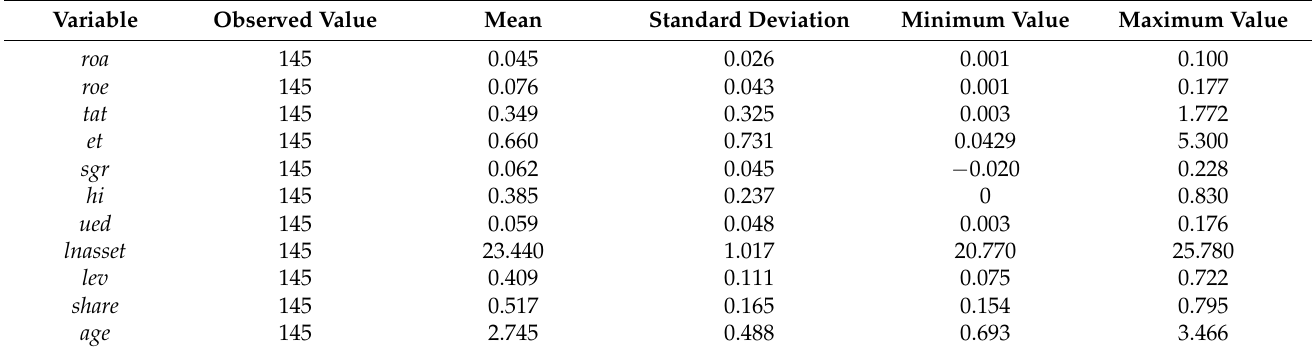
Table 3. Descriptive statistics of the variables.